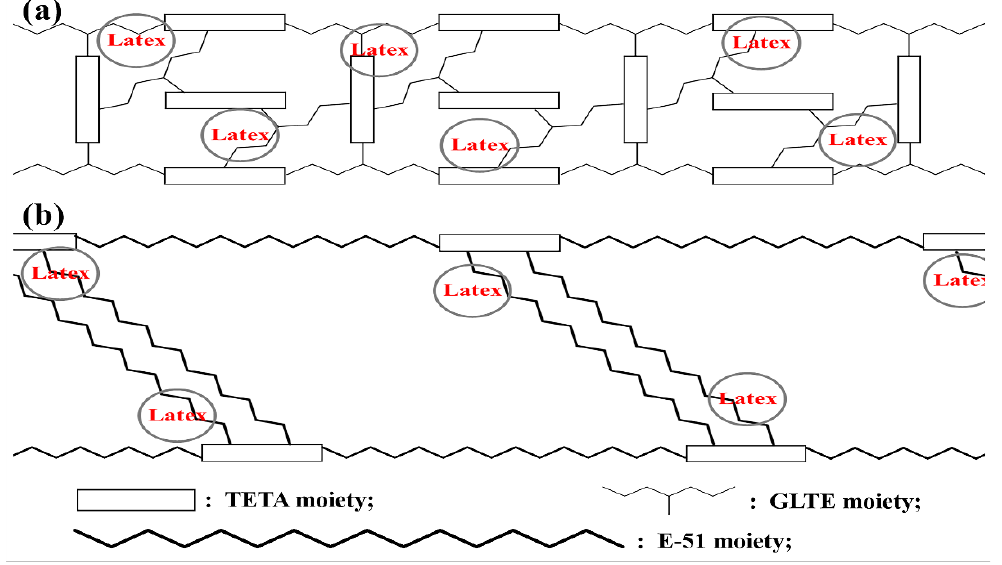
Figure 9. Schematic diagram of the curing network structure of ( a ) the micromolecular GTL system and ( b ) the macromolecular ETL system.